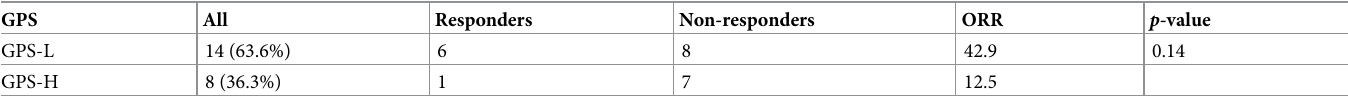
Table 3. Response rates according to